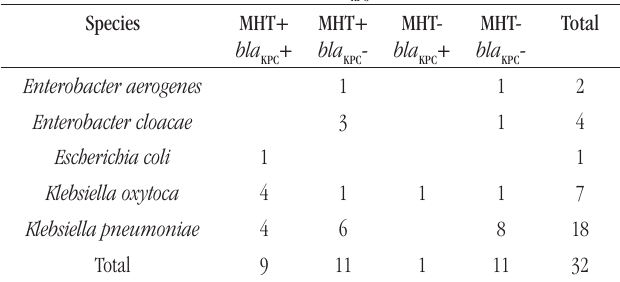
taBLE – Profiles of isolates according to the modified Hodge test and bla